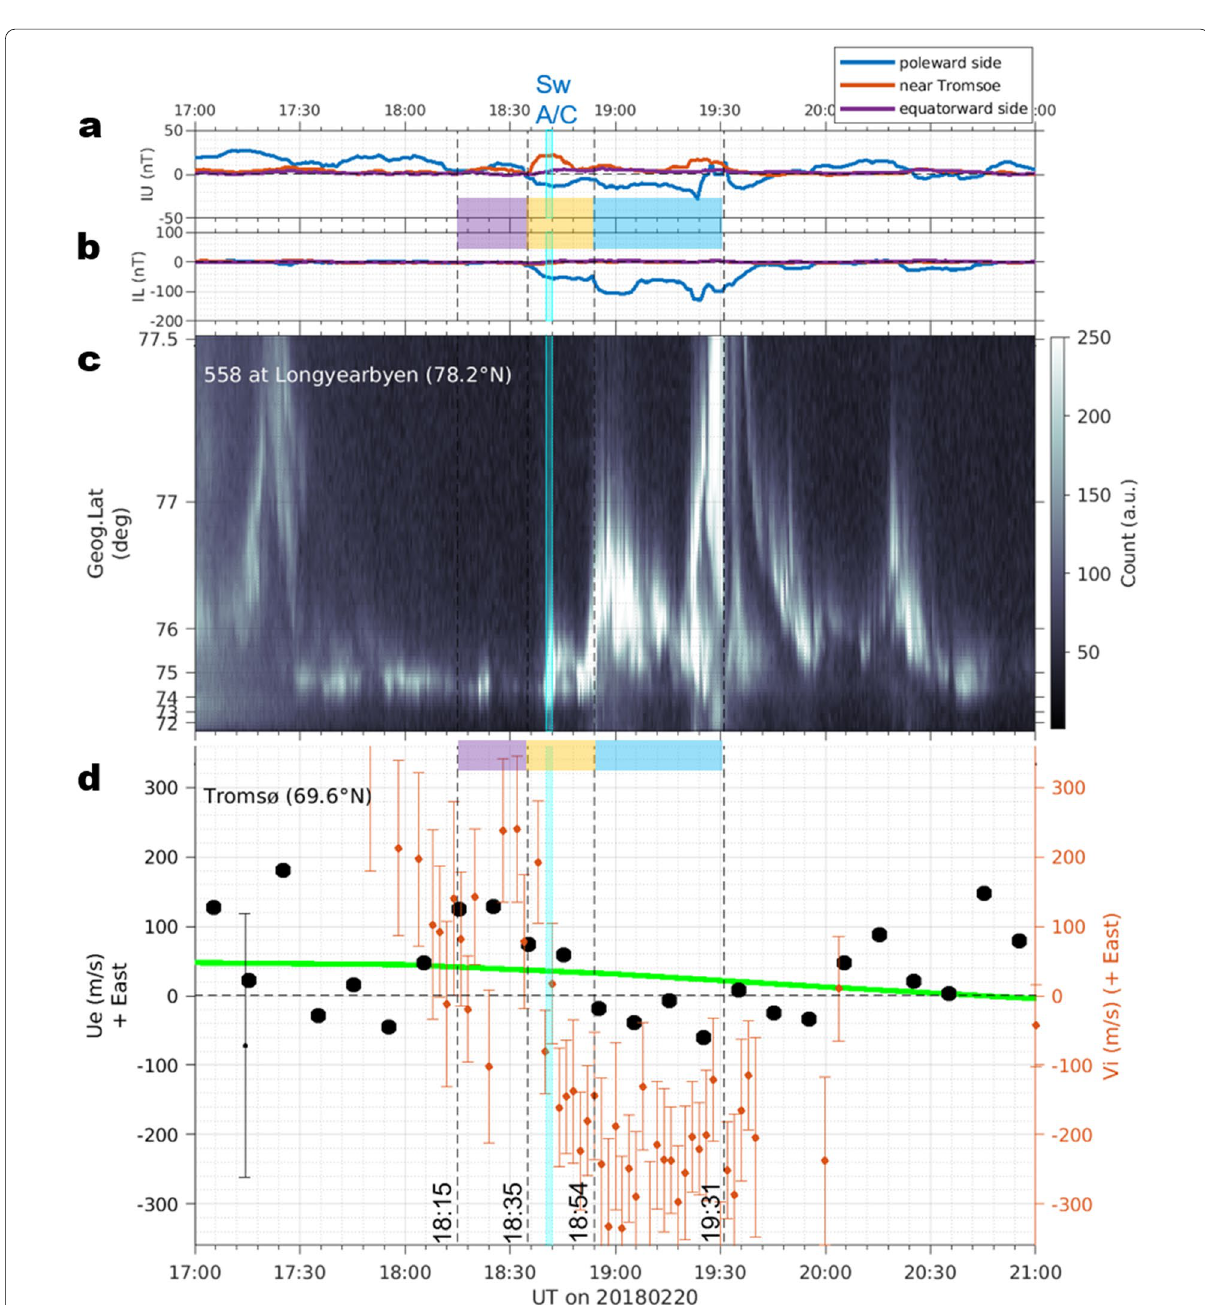
Fig. 3 Time series of a IU, b IL, c keogram made of the all‑sky camera at Longyearbyen (but from 72 to 77.5°N) and d zonal component of the FPI‑measured neutral wind (black dots) and ion velocity from the Dynasonde (orange dots) at Tromsø from 17 to 21 UT on 2018 February 20. Post‑integration of 4 FPI fringe images was applied, corresponding to a 10‑min time resolution. The mean error of the neutral wind for the selected four hours is illustrated by a black vertical bar. Individual errors of the ion velocity are marked by orange vertical bars. The green curve represents the HWM zonal wind at 250‑km altitude. The time of the Swarm pass over Scandinavia is marked by a vertical light blue bar, which is drawn from 18:40:18 to 18:42:08 UT, corresponding to the shifted geographical latitude from 67 to 74°N (see Fig. 4c). The time interval from 18:15 to 19:31 UT is separated into three groups, highlighted in purple, yellow, and light blue. These colors are also applied in Fig. 6 to highlight individual time